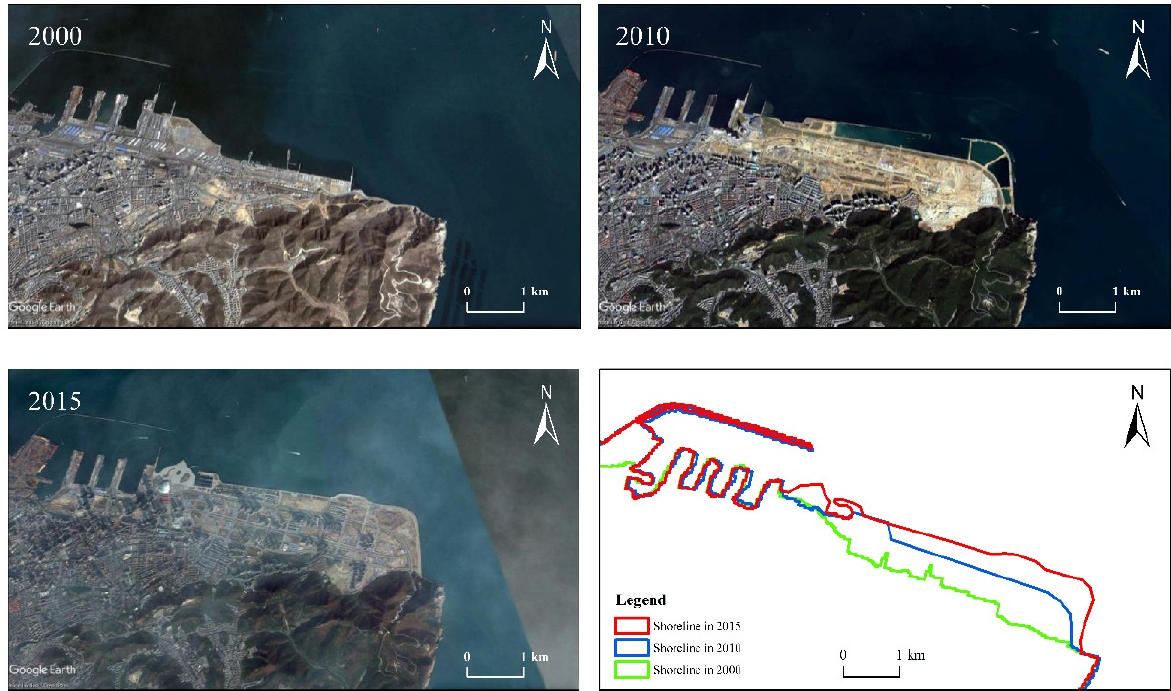
Figure 3. Comparison of coastline changes in Dalian between 2000 and 2015.